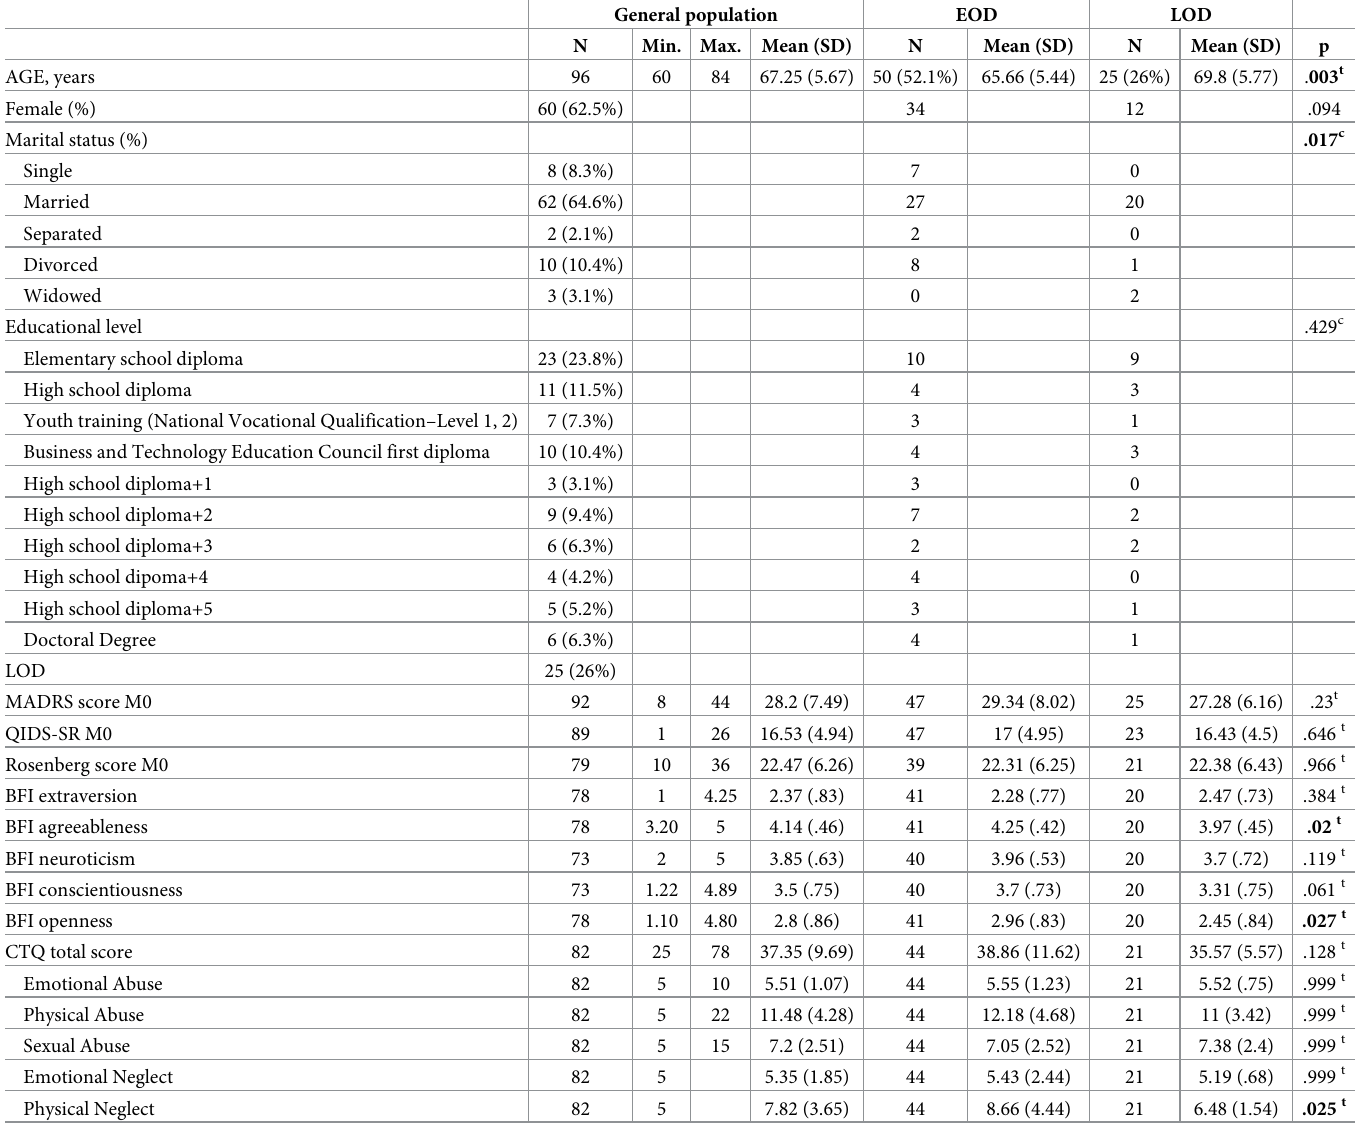
Table 1. Population